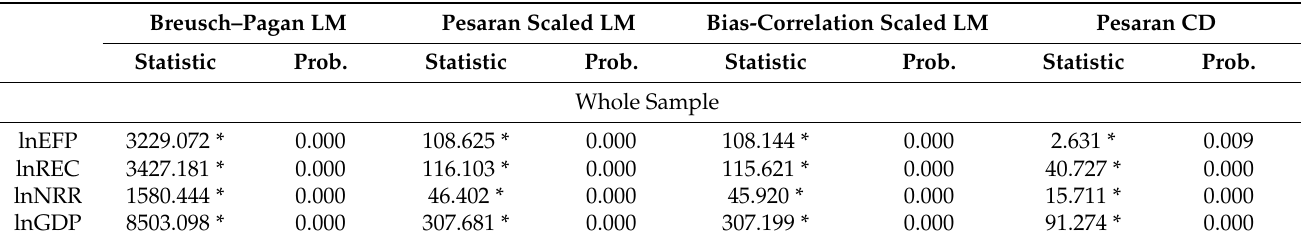
Table 4. Cross-sectional dependence test